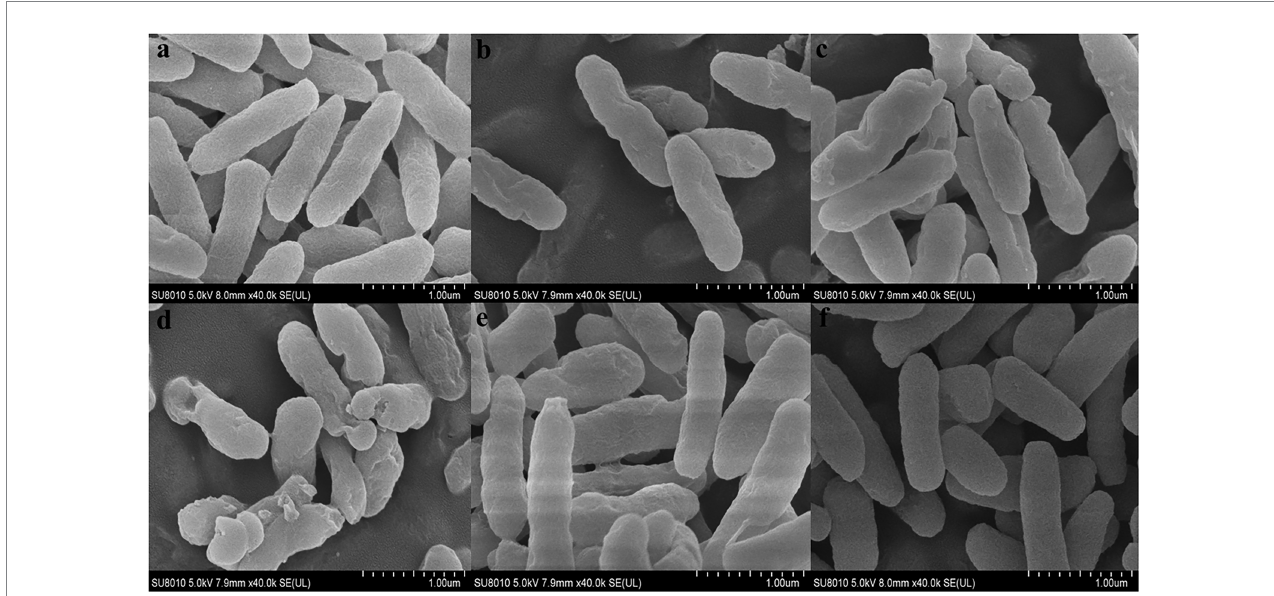
FIGURE 5 Effect on morphology of Pseudomonas aeruginosa cells. (A) Shows the Control group. (B) Shows the experimental group treated with FA. (C) Shows the experimental group treated with FC3. (D) Shows the experimental group treated with FC6. (E) Shows the experimental group treated with FC9. (F) Shows the experimental group treated with FC12.